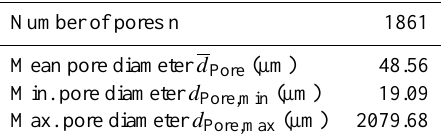
Table 3. Results of the pore-size distribution highlighting values for number of pores as well as mean, minimum and maximum pore